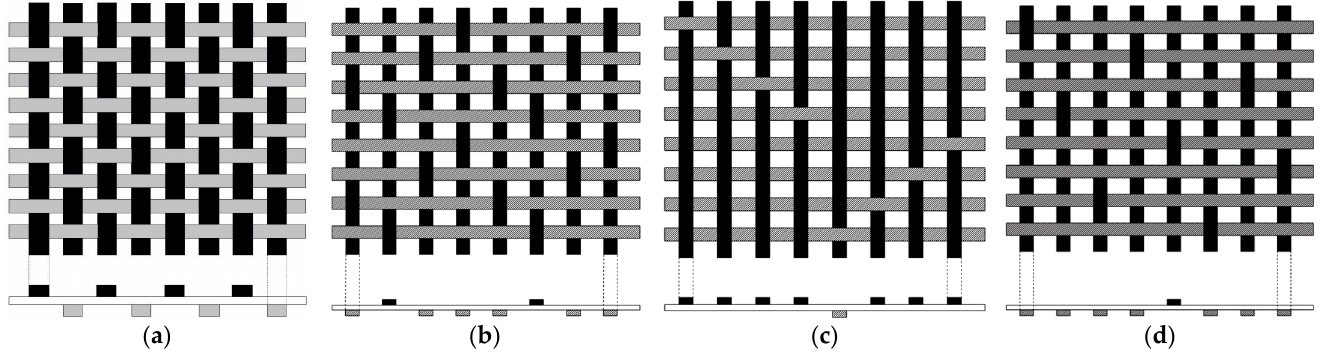
Figure 10. Various weave forms of GF ( a ) Plain weave ( b ) 4-harness satin weave—120GF ( c ) 8-harness satin weave—1581GF ( d ) 8-harness satin weave—181GF [92].